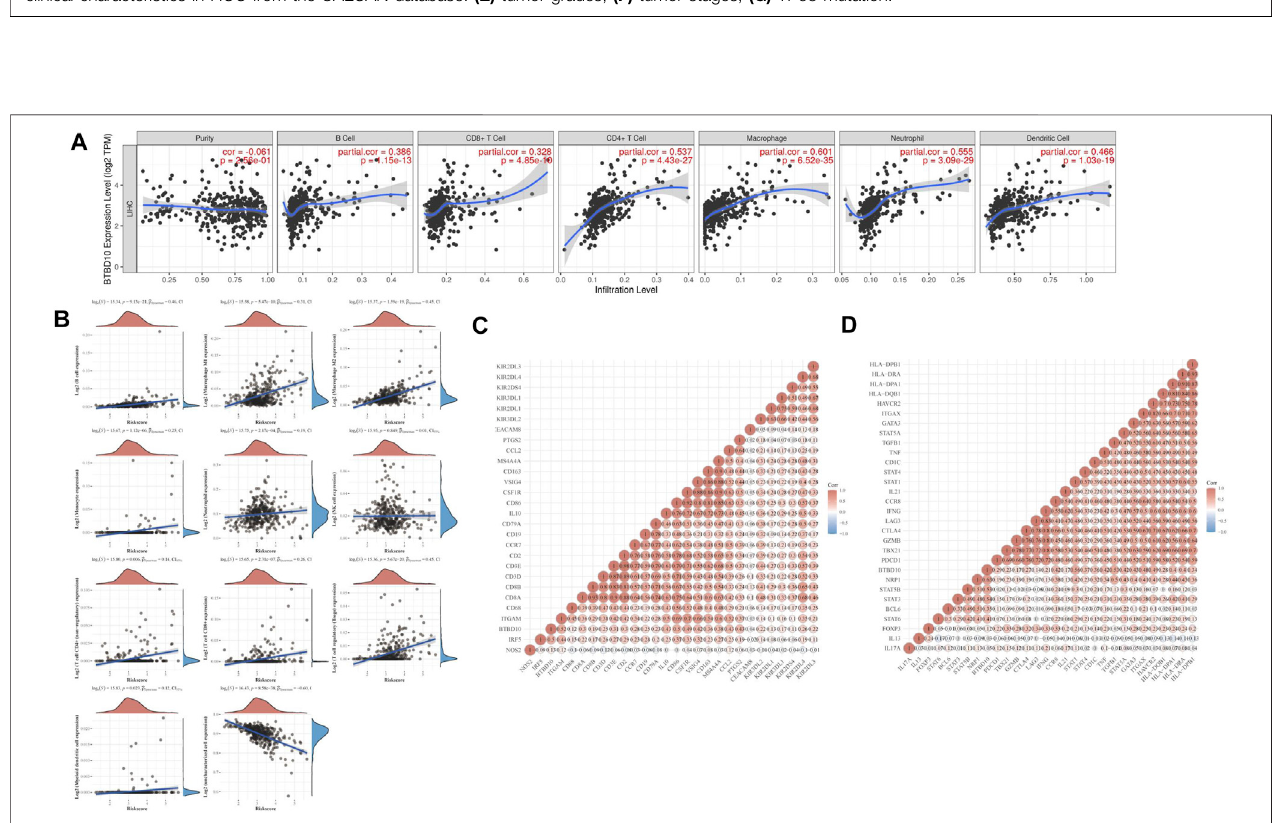
FIGURE 5 | Association between expression of BTBD10 mRNA and clinical characteristics in HCC from the UALCAN database. (A) tumor grades; (B) tumor stages; (C) TP53 mutation. (D) Promoter methylation level of BTBD10 in HCC. Association between expression of Promoter methylation level of BTBD10 mRNA and clinical characteristics in HCC from the UALCAN database. (E) tumor grades; (F) tumor stages; (G) TP53 mutation.